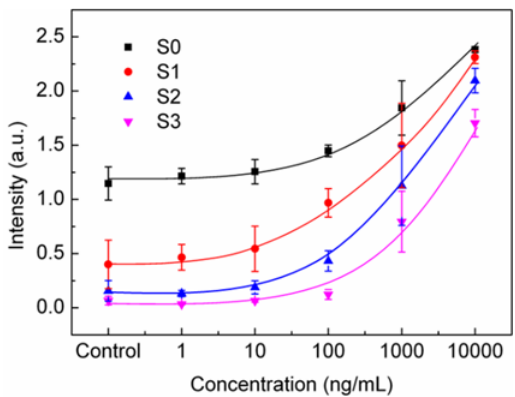
Figure 6. The mean value of SPR responses for different anti-BSA concentrations and threshold values. S0, S1, S2, and S3 correspond to the average plus 0, 1, 2, 3 times standard deviations of the control experiments, respectively ( n = 3).